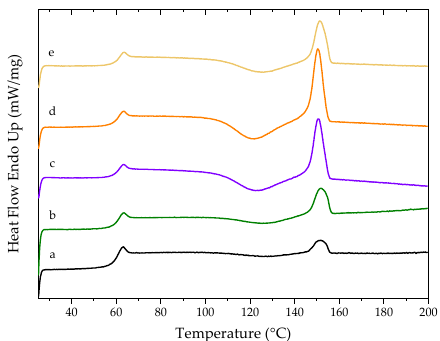
Figure 11. The second heating DSC thermograms of PLA and PLA/nHAp composite films with nHAp from different preparation steps and 1DP − nHAp at various contents (a) PLA, (b) PLA/1DP − nHAp , (c) PLA/1DP − nHAp , (d) PLA/2DP − nHAp , and (e) PLA/1DP − nHAp . 2.5 5 5 10